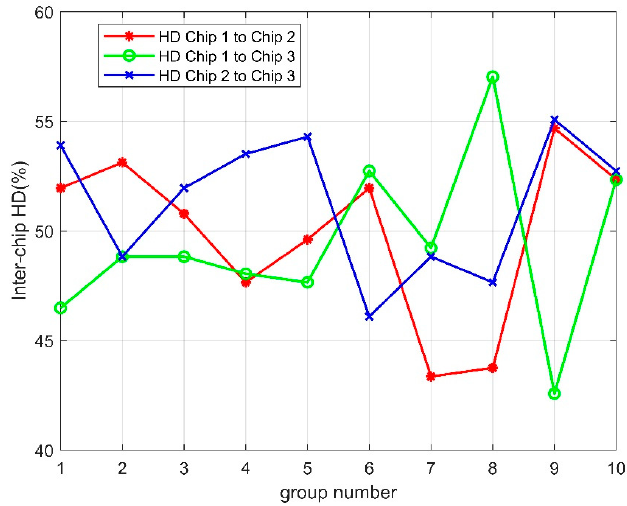
Figure 7. The inter-chip HD in the lightweight scheme. Different temperatures have a large impact on the stability of SRAM, so the initial SRAM values for three chips in the same region were tested at temperatures of − 20 °C, 40 °C and 80 °C. The data at 20 ° C was used as the standard matrix and verification matrix. The algorithm above was used to process the same location data at different temperatures. The SRAM worked normally as it would at 20 °C at − 40 °C and 80 °C. As is shown in table 3, the three chips produced the same results at different temperatures based on the verification matrices that were saved, indicating that the lightweight scheme was able to perform well at different temperatures.